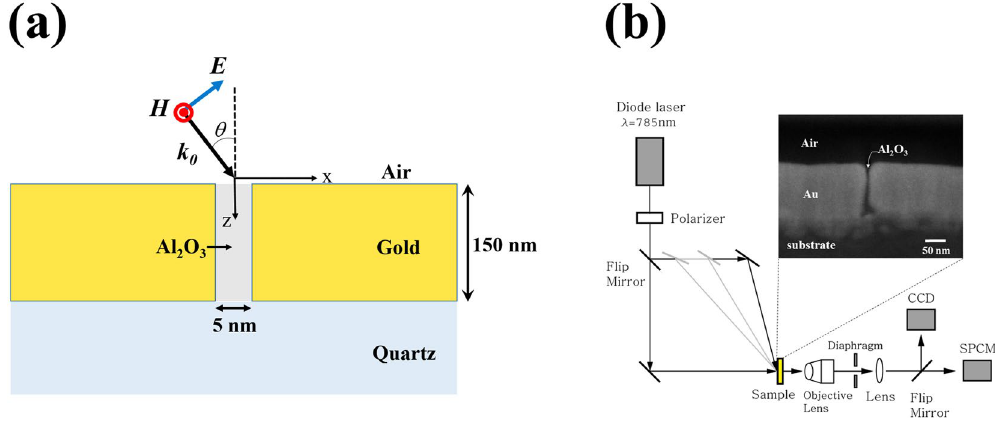
Figure 1. ( a ) Schematic of the problem with a p-polarized oblique incidence. ( b ) Schematic of the experimental setup. The incident angle was adjusted by moving the location of the incidence mirror. The transmitted light through the sample was collected by an objective lens with a NA of 0.25. Lightpath to SPCM or CCD was selected by using a flip mirror. Inset: cross-sectional SEM image of a 5-nm gap.